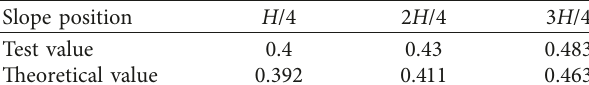
Figure 18: Variation of displacement with location. Table 2: Critical seismic acceleration factor.